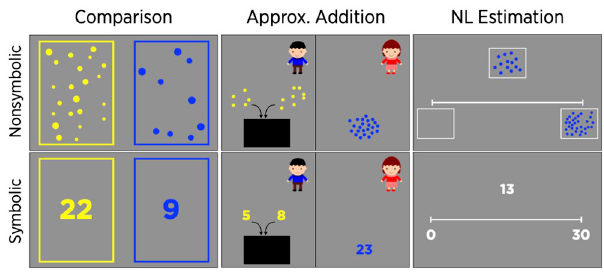
Fig 2. Numerical magnitude tasks. Illustration of non-symbolic and symbolic number